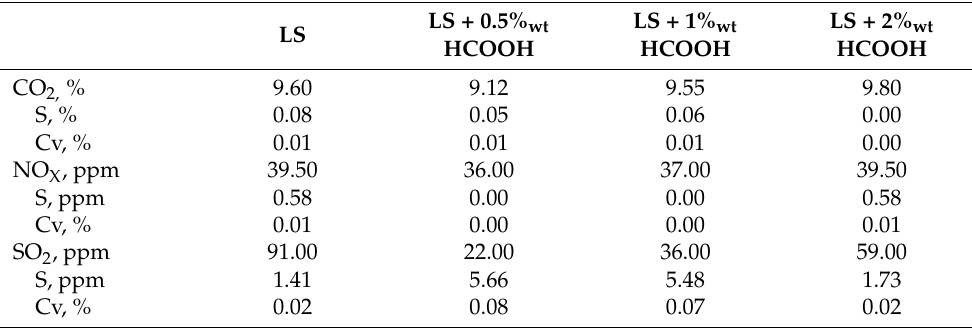
Table 3. Cont. After cleaning of flue gases in the gas washing bottle (M.P.5)